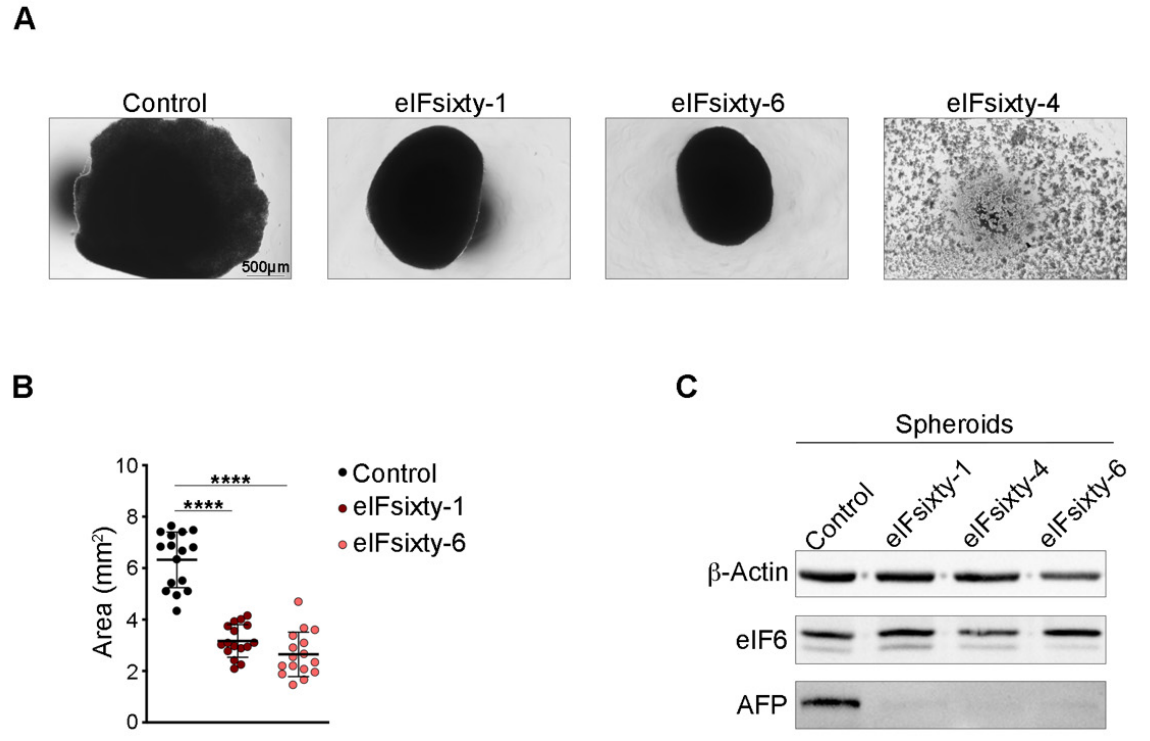
Figure 6. eIF6 pharmacological targeting impairs the growth of HCC spheroids. ( A ) Brightfield images of spheroids derived from Huh7.5 cells treated with eIFsixty-i compounds. The following concentration were used: eIFsixty-1, 1.4 µ M; eIFsixty-4, 5 µ M; eIFsixty-6, 1 µ M. Scale bar is indicated. ( B ) Area of eIFsixty-1- and eIFsixty-6-treated spheroids is reduced compared to the untreated control. Area is expressed in mm 2 . Bold black line indicates mean ± SD. Each dot represents a single spheroid. Results of two-tailed t tests are shown. **** p value ≤ 0.0001. ( C ) Representative Western blotting of eIFsixty-i-treated spheroids for eIF6 and AFP. β -Actin was used as a loading control.